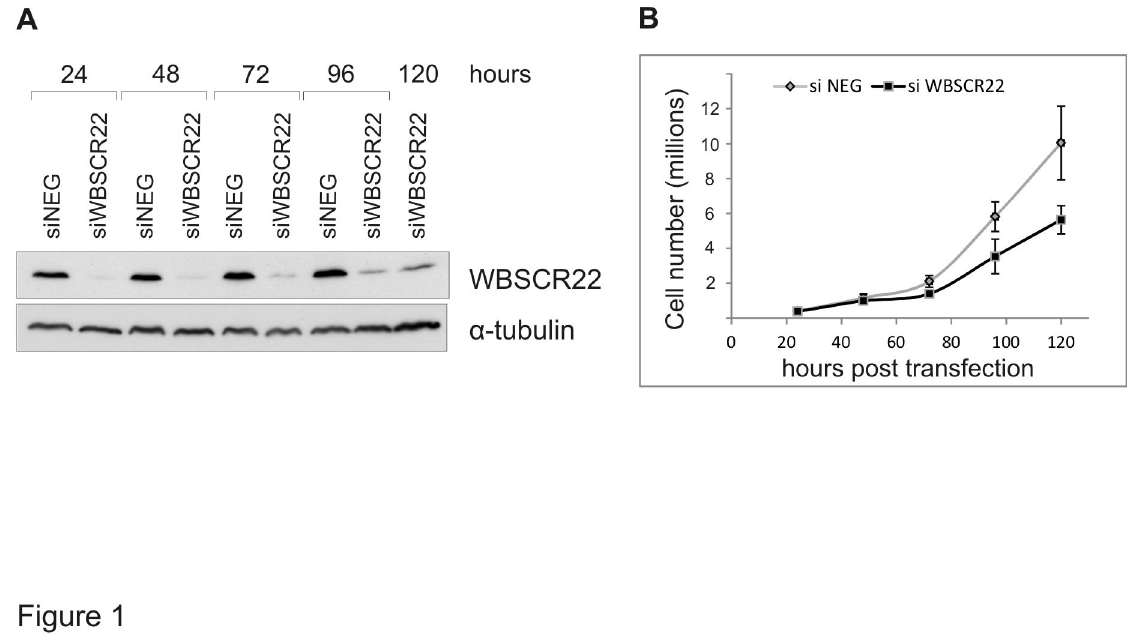
Figure 1. Depletion of WBSCR22 reduces cell growth. (A) Protein expression of siWBSCR22 and siNeg. transfected cells was determined by western blot analysis using anti-WBSCR22 and anti-tubulin antibodies. Proteins from 10 5 cells are loaded on each lane. (B) HeLa cells were transfected with siWBSCR22 or a control, siNeg, and the cell growth was monitored for five days. Average of three independent transfection experiments is shown. doi: